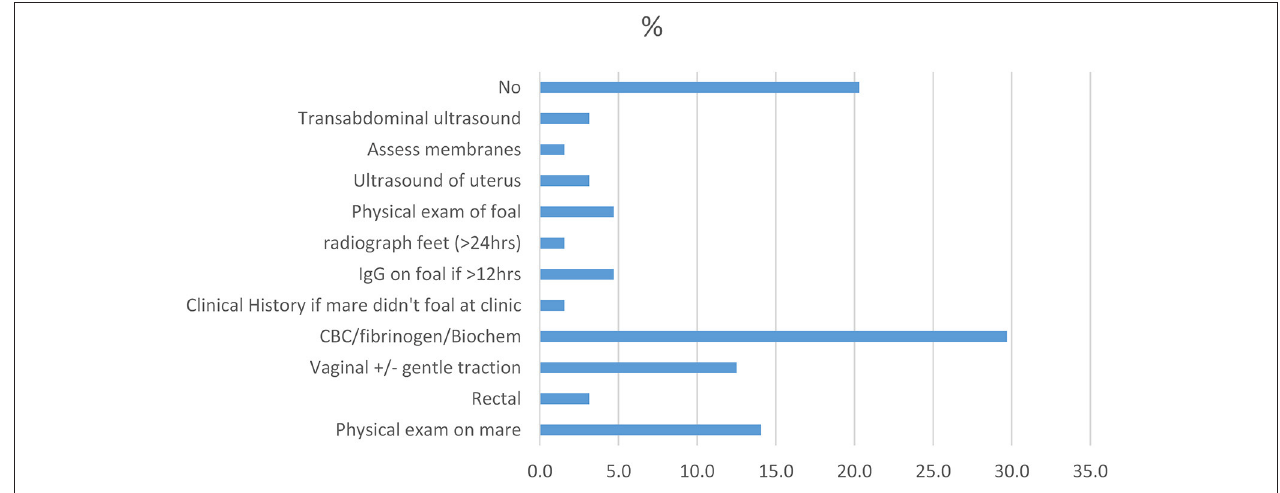
FIGURE 2 | Diagnostics performed by practitioners in mares with RFM ( n = 64).